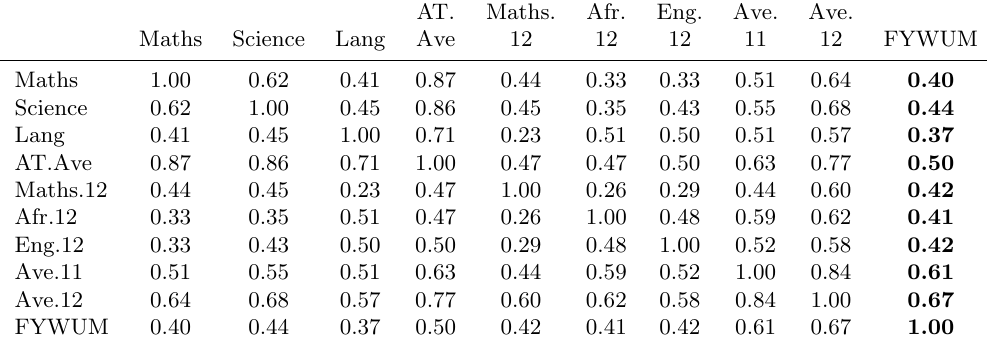
Table 11: Inter-correlations among the Test Battery 1 variables – 2001 [Critical r = 0 . 07 (5% significance level), 0.10 (1% significance level)].